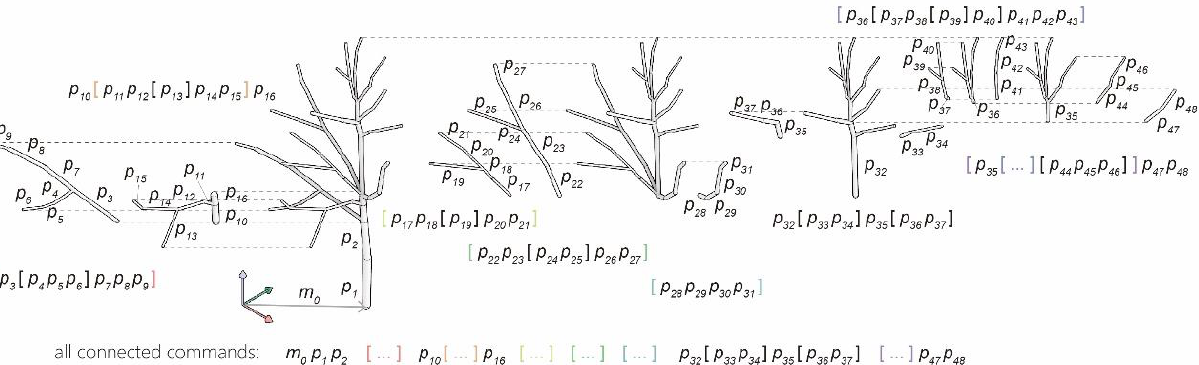
Figure 6. Connecting all turtle commands to represent the topology of a tree.